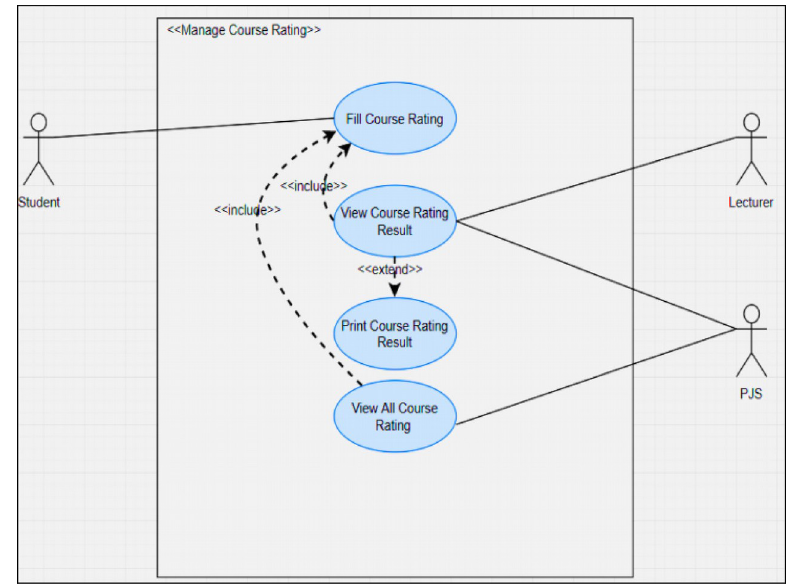
Figure 2. Use case design of interaction between lecturers, students, and faculty management (PJS actor in the figure) in the course rating sub-system